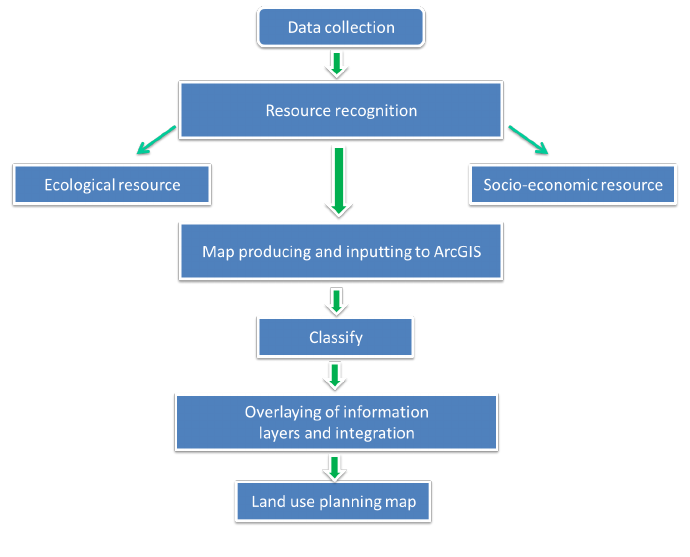
Figure 2: Process of